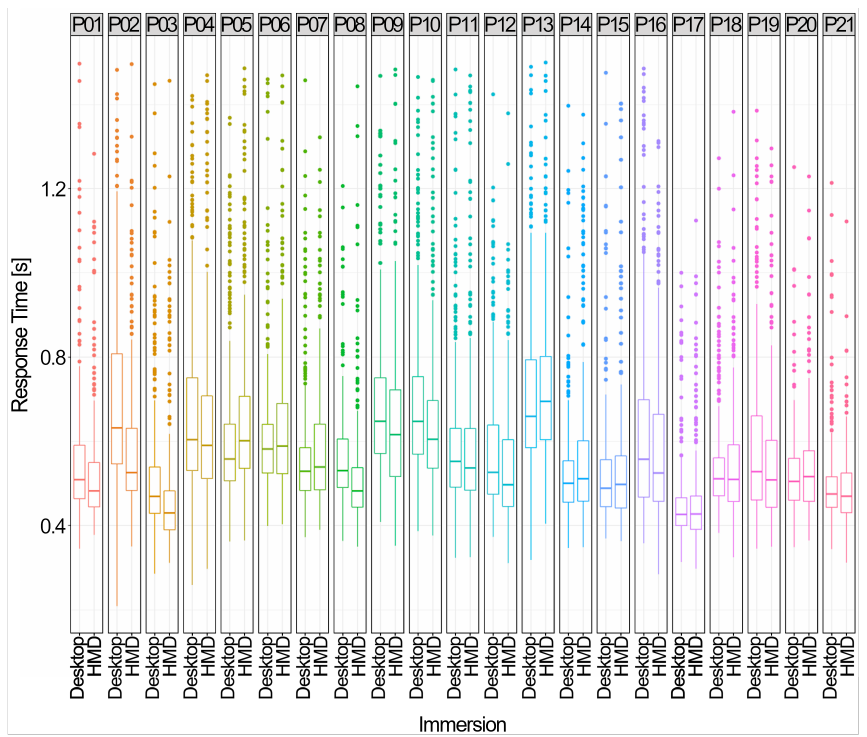
Figure 9. Box-and-Whiskers Plots of response times of each participants comparing HMD and desktop display conditions. Lower and upper hinges correspond to the first and third quartiles (i.e., the 25th and 75th percentiles). Upper and lower whisker extends from the hinge to the largest value no further than 1.5 interquartile ranges from the hinge. The points indicate outliers evaluated as data points beyond the whiskers. P01 to P21 indicate individual participants.